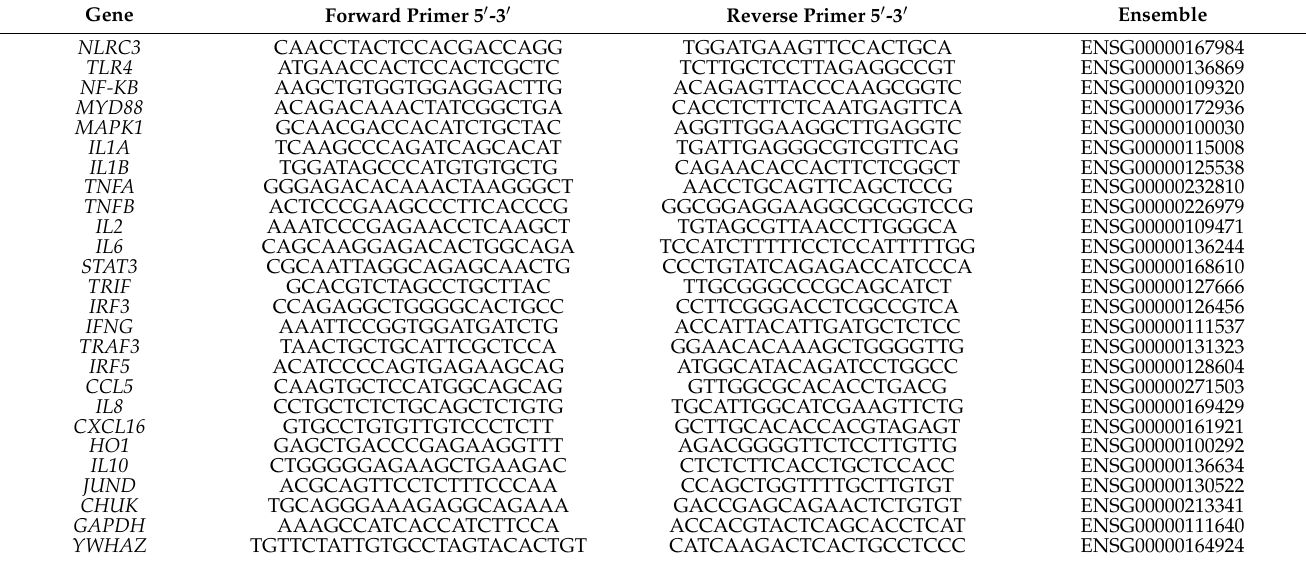
Table 2. Primers used for real-time qPCR and the mean PCR efficiency for each gene as calculated by LinRegPCR software [37].